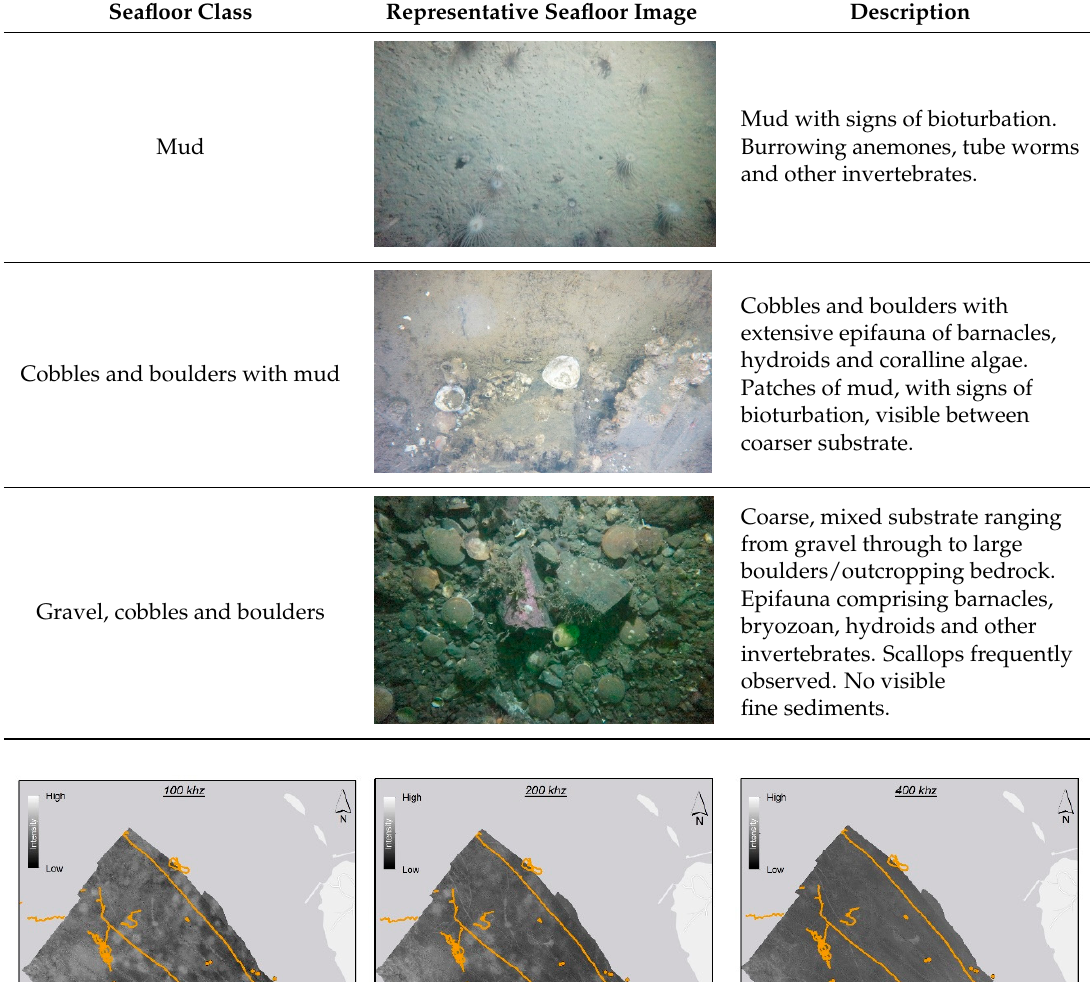
Figure 6. Classified video and photographic ground truthing data sets overlaid on a combined 2016 and 2017 100 kHz backscatter mosaic. Table 1. Seafloor classes derived from visual analysis of the subsea video and photographic data sets.